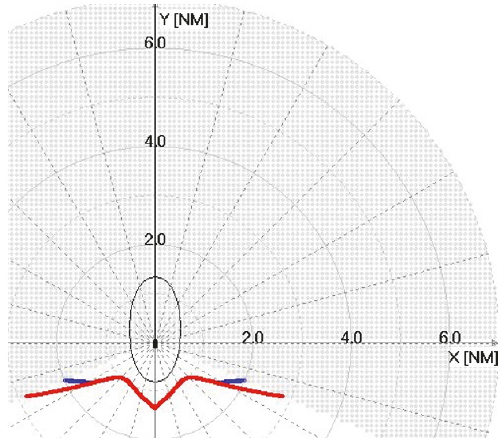
Figure 14: Action lines for being overtaken by a target, whose true speed is 23 knots. Turns to both sides are considered depending on target’s relative bearing. A turn of 15 ∘ without speed reduction (red) and with a 3-knot reduction (blue) is compared.